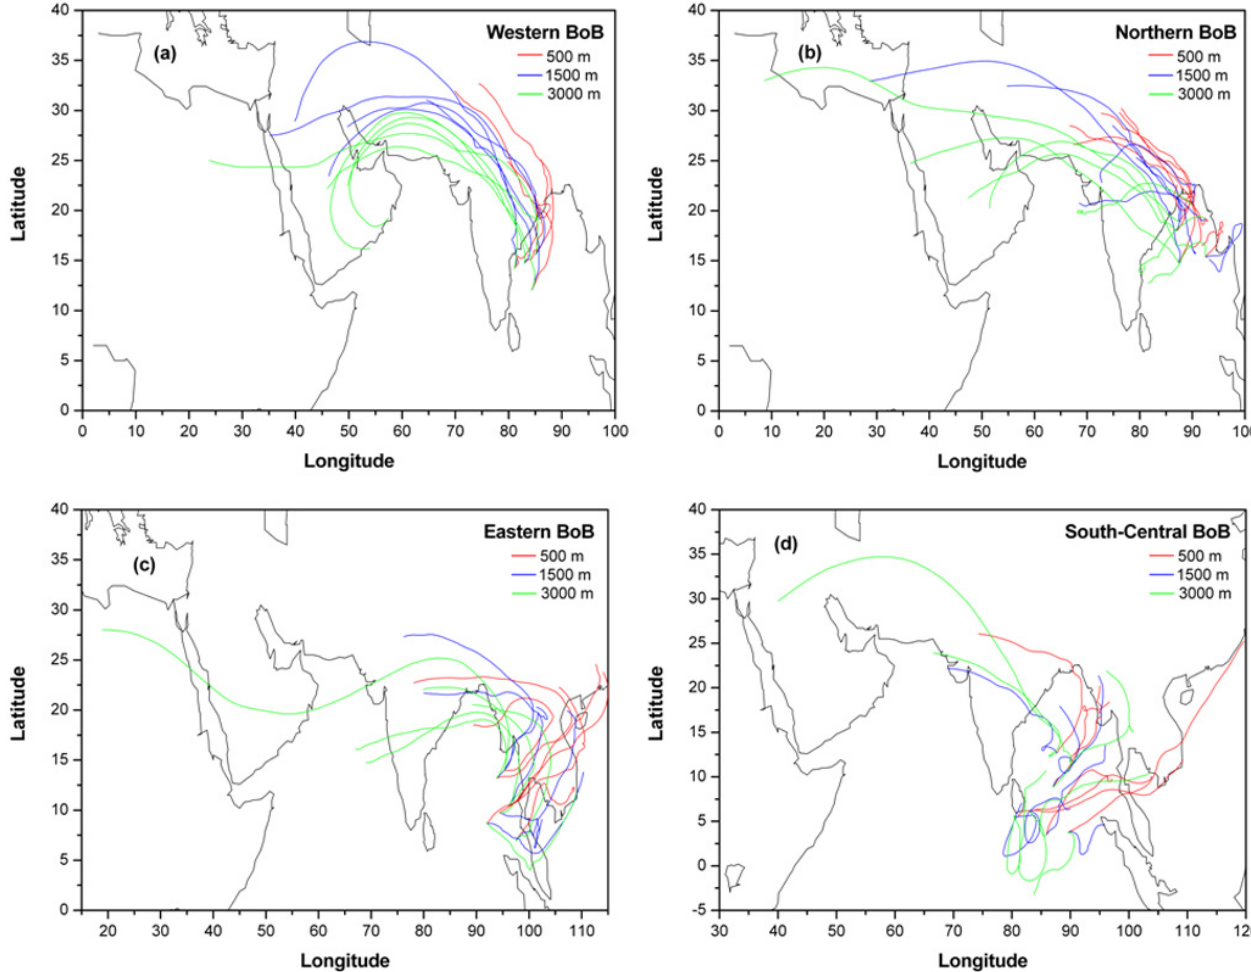
Fig. 8. Five days back trajectories by means of HYSPLIT model at 500m, 1500m, and 3000m, for all the days of the W-ICARB campaign. The cruise track period has been divided into 4 parts depending on the ship location (west BoB, north BoB, east BoB and south-central